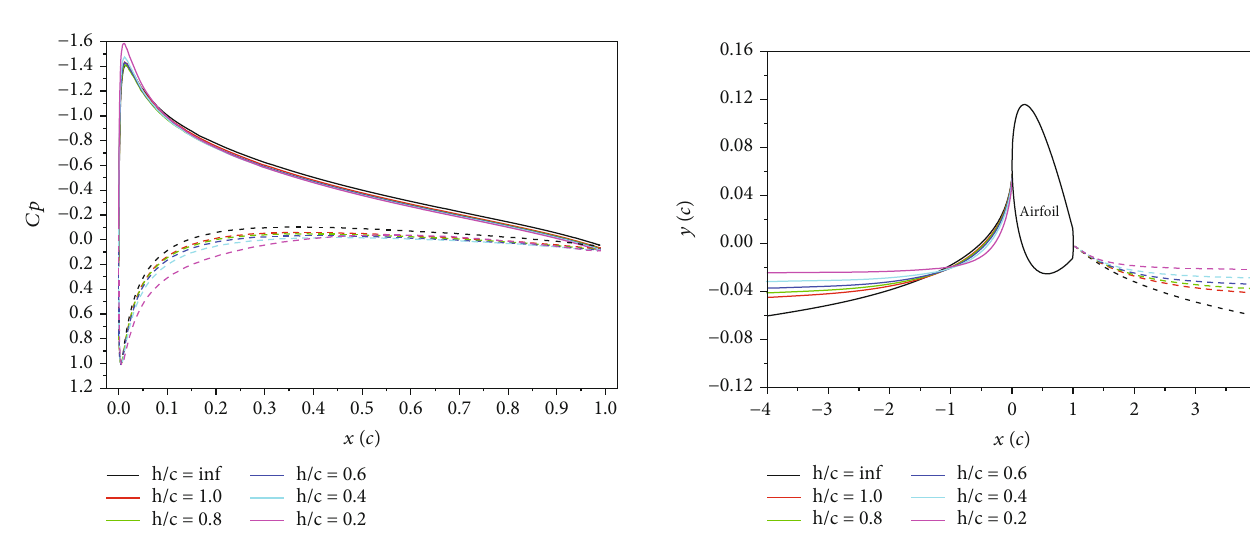
Figure 23: Leading and trailing edge stagnation streamlines for the no-blowing case at α = 4 °